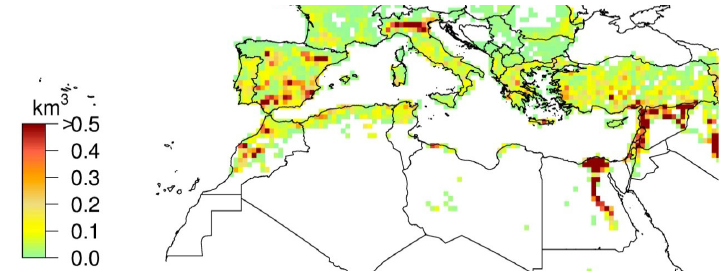
Figure 1. Annual absolute gross irrigation water requirements (GIR), as average for the period 2000–2009, at a 30arcmin